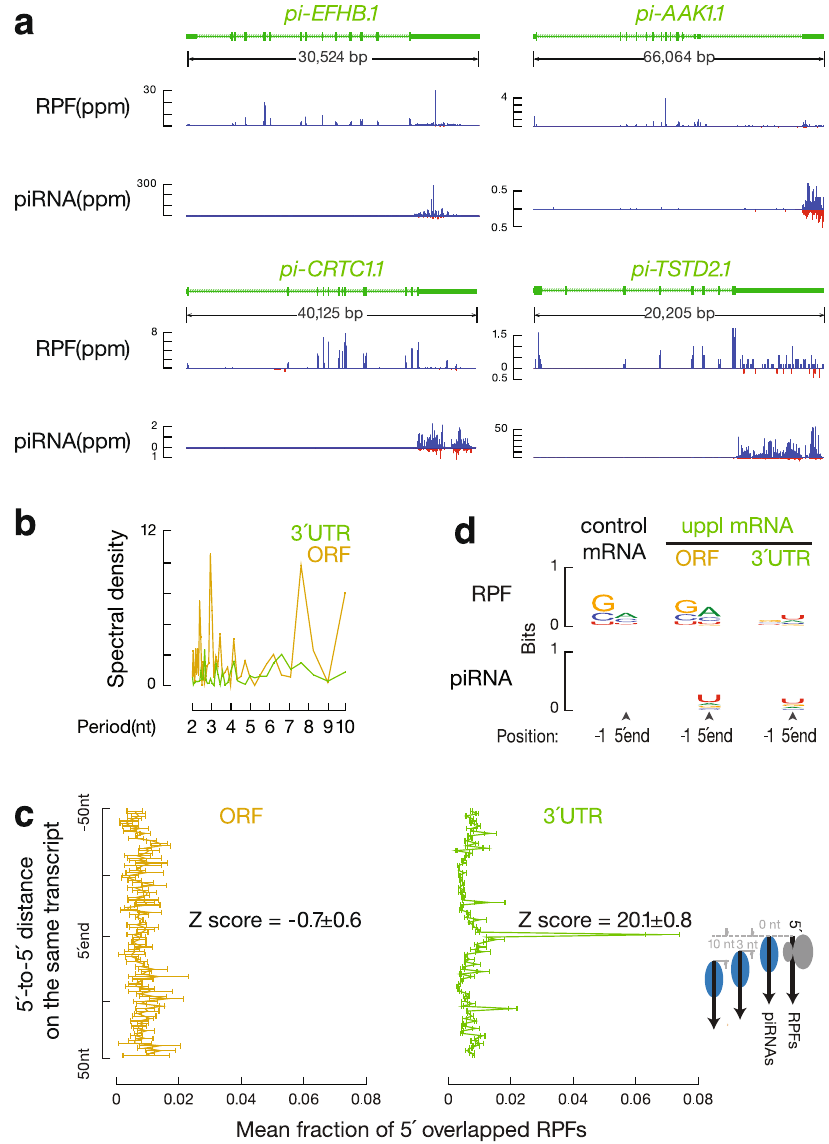
Fig. 6 Ribosome-guided 3 ′ UTR piRNA formation is evolutionarily conserved. a Normalized reads of RPFs and piRNAs mapping to four representative chicken uppl genes in adult rooster testes. In roosters, both strands of uppl mRNAs code for piRNAs; blue represents Watson strand mapping reads; red represents Crick strand mapping reads. b Discrete Fourier transformation of the distance spectrum of 5 ′ -ends of RPFs across ORFs (gold) and 3 ′ UTRs (green) of chicken uppl mRNAs in adult rooster testes. c Distance spectrum of 5 ′ -ends of RPFs from uppl ORFs (left) and from 3 ′ UTRs (right) that overlap piRNAs in adult rooster testes (sample size n = 3 independent biological replicates). Data are mean ± standard deviation. d Sequence logos depicting nucleotide bias at 5 ′ -ends and 1 nt upstream of 5 ′ -ends of the following species from adult rooster testes. Top to bottom: RPF species and piRNAs, which map to control mRNAs, uppl ORFs, and 3 ′ UTRs,